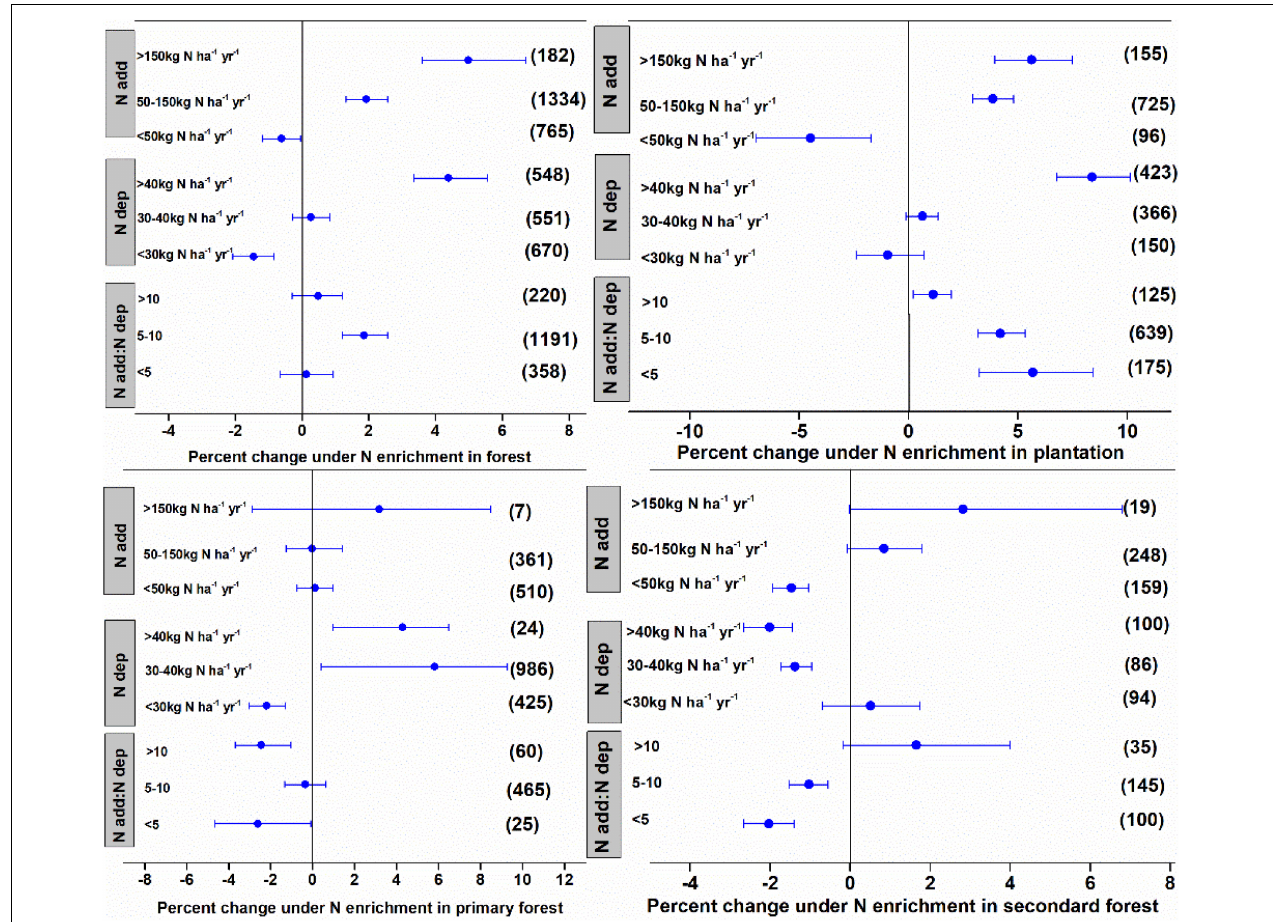
FIGURE 3 | Mean percent change in litter mass remaining after N enrichment, ambient N deposition, and the ratio of N addition:ambient N deposition in the forest. The data were further grouped according to the community successional stages of the plantation, primary forest, and secondary forest. Differences in mean levels were regarded as significant if the 95% CIs did not overlap zero. Values in brackets represent the number of observations for each ecosystem